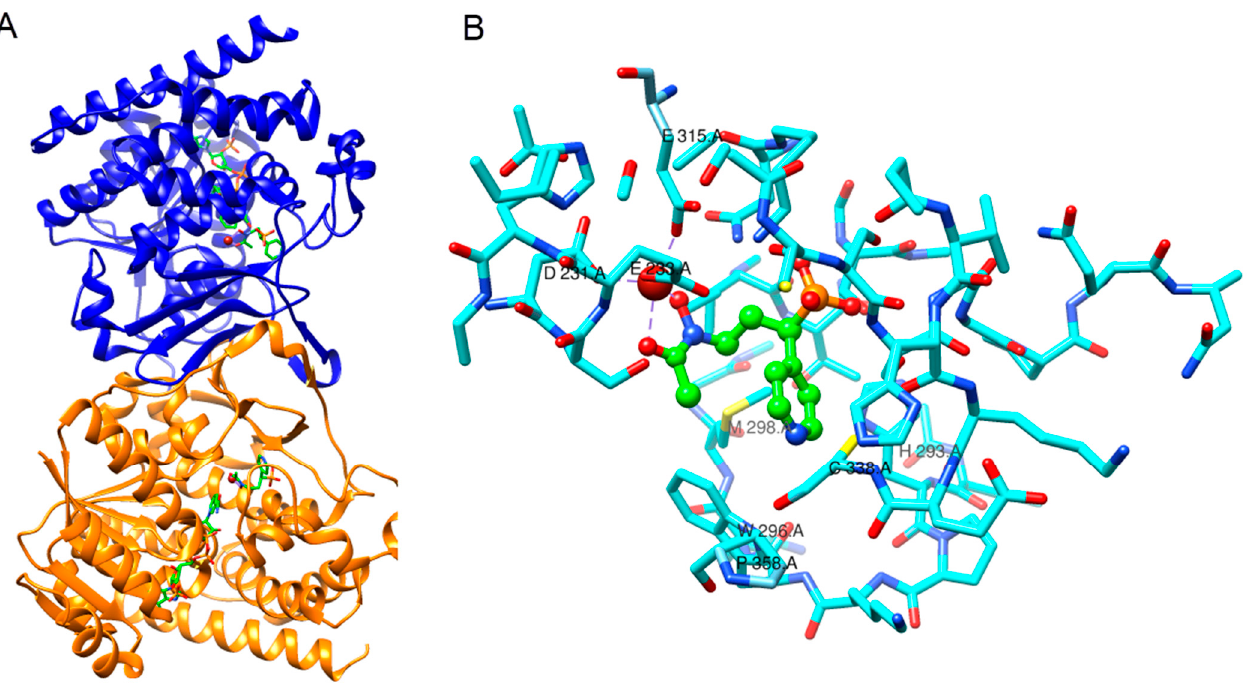
Figure 23. ( A ) overall structure of Pf DXR in complex with Mn 2+ (brown sphere), 106b (green) and NADPH. ( B ) Close-up view of the active site of Pf DXR: 106b . Reproduced from Xue et al. (PDB: 4GAE [139] .